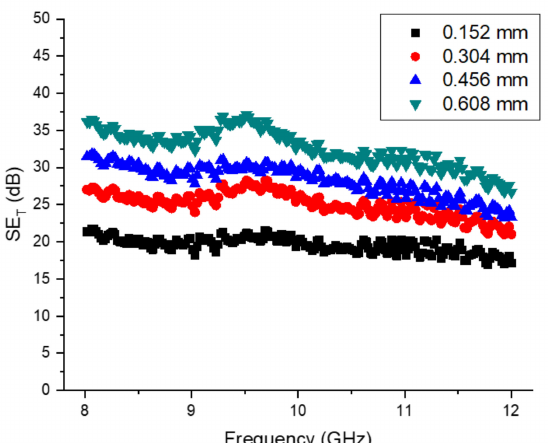
Figure 9. Effect of thickness on total shielding efficiency of CH/Na/CuSe polymer matrix with 20 wt% of CuSe filler.